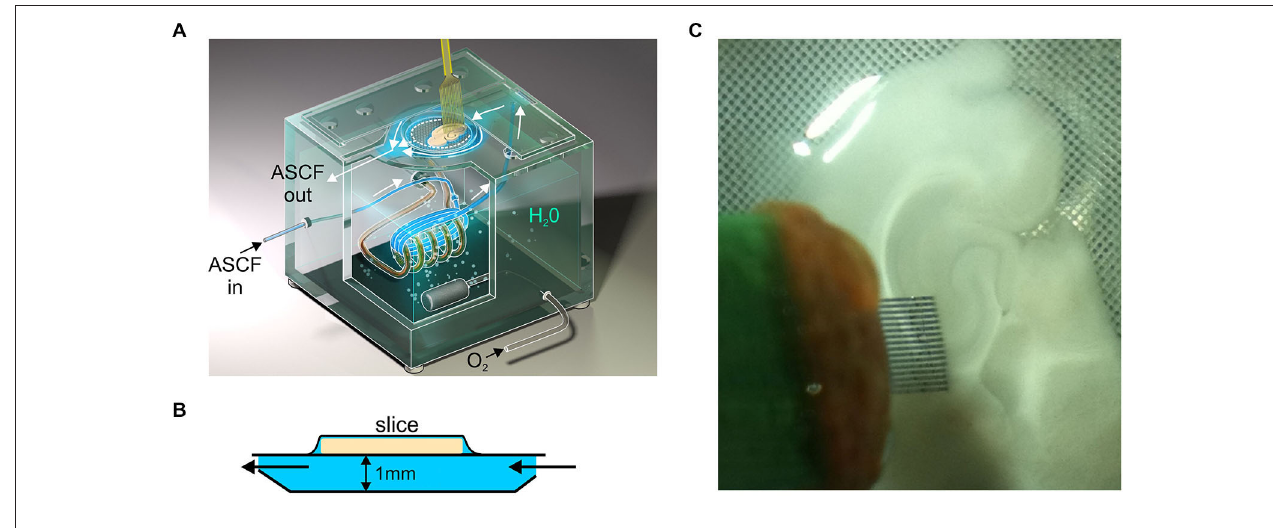
FIGURE 1 | Scheme of recordings in the modified interface chamber. (A) Orthogonal scheme of the modified interface chamber. Slice is placed on the plastic mesh and its inner surface is superfused with ACSF to improve oxygenation at the bottom of slice and to